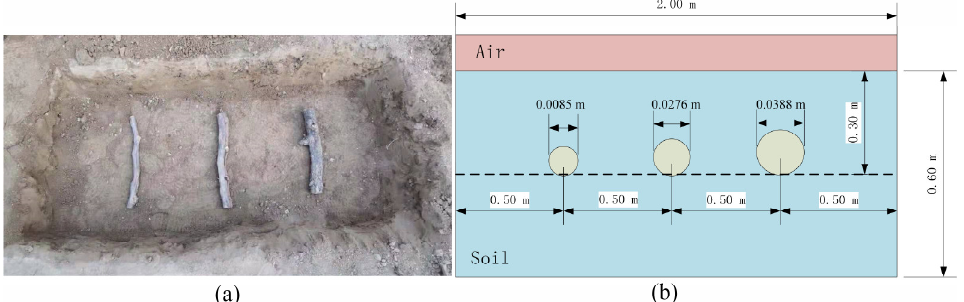
Figure 13. The site for controlled experiments. ( a ) The designed experiment for roots with different radius. ( b ) The geometric model for the corresponding experiment.